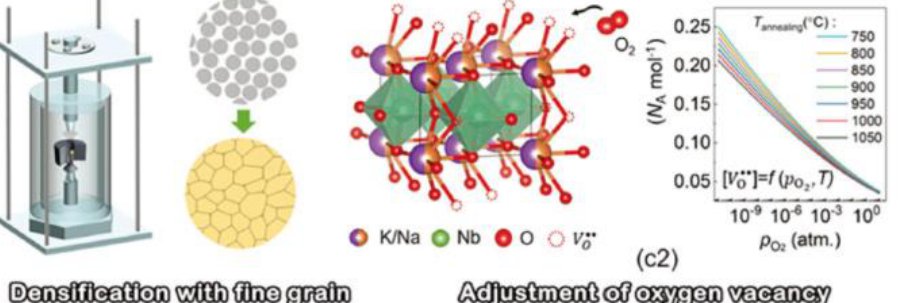
Figure 2. ( a ) P(E) loops of unpoled (xSb, Mn)-doped PZT ceramics at 1 Hz (i) and d 33 , k p , and Q m of poled (xSb, Mn)-doped PZT ceramics (ii) [37]. ( b ) Schematic illustrations for a facile inkjet-printing process and ink solvent evaporation mechanism in the printed droplet [53]. ( c ) Hot-pressing combined with a post-annealing process for the KNN preparation [46].